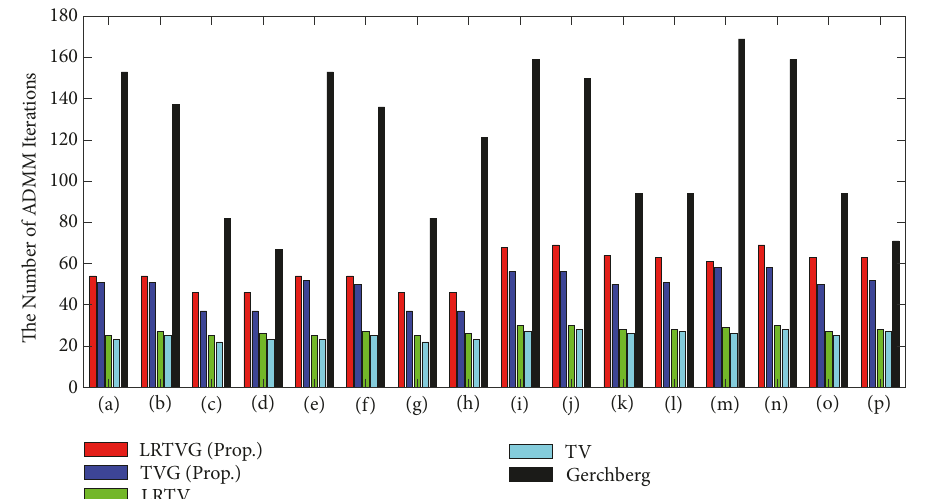
Figure 5: The numbers of iterations until the ADMM convergence. Each threshold of the stopping criteria was 1.0 × 10 −7 .